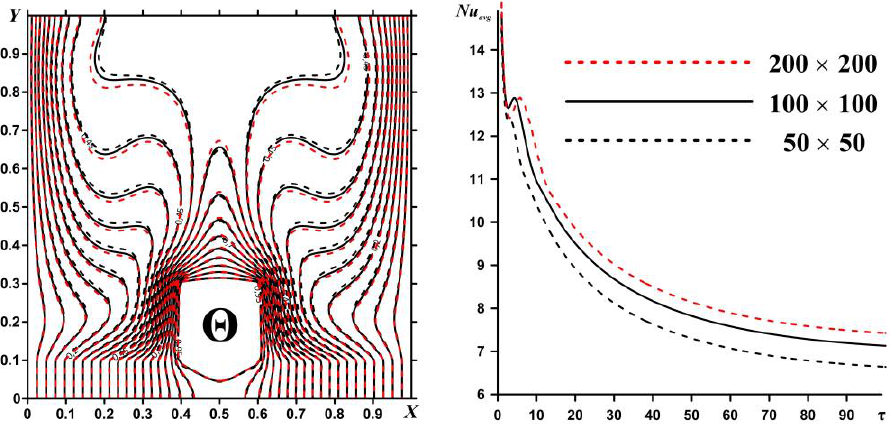
Figure 3. Isotherms and average Nusselt numbers for different meshes.